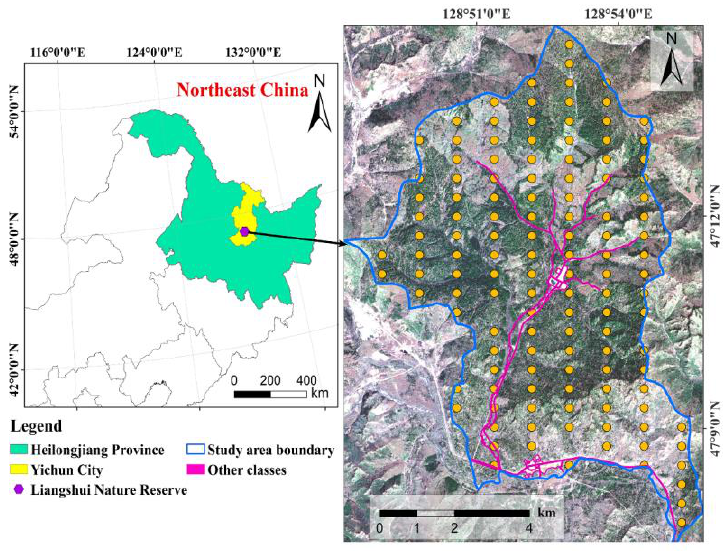
Figure 1. Overview of the Northeast China Liangshui Nature Reserve study area and the distribu- tion of sample plots. of sample